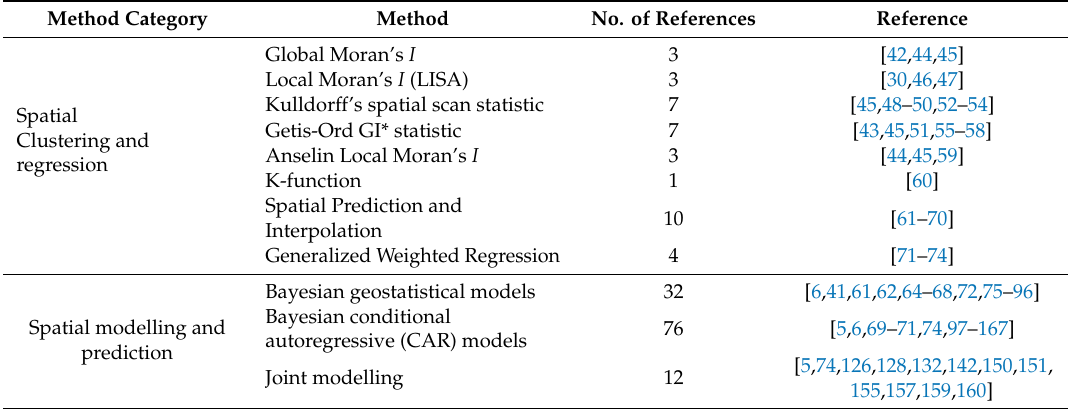
Table 2. Main spatial analysis techniques used in data